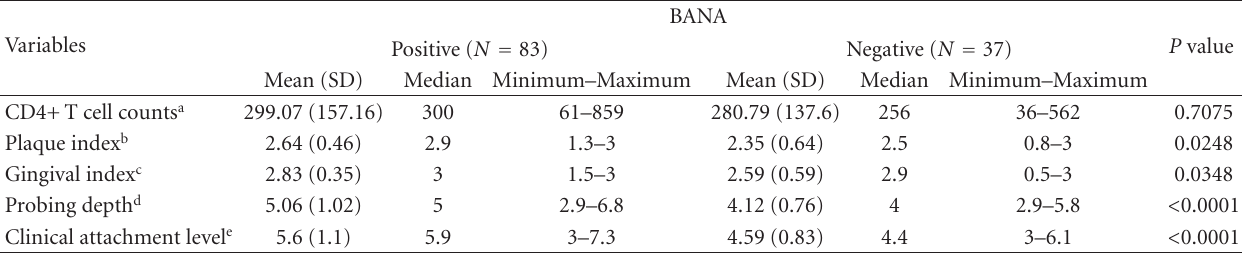
Table 1: CD4+T cell counts and clinical indices relative to frequency of BANA.